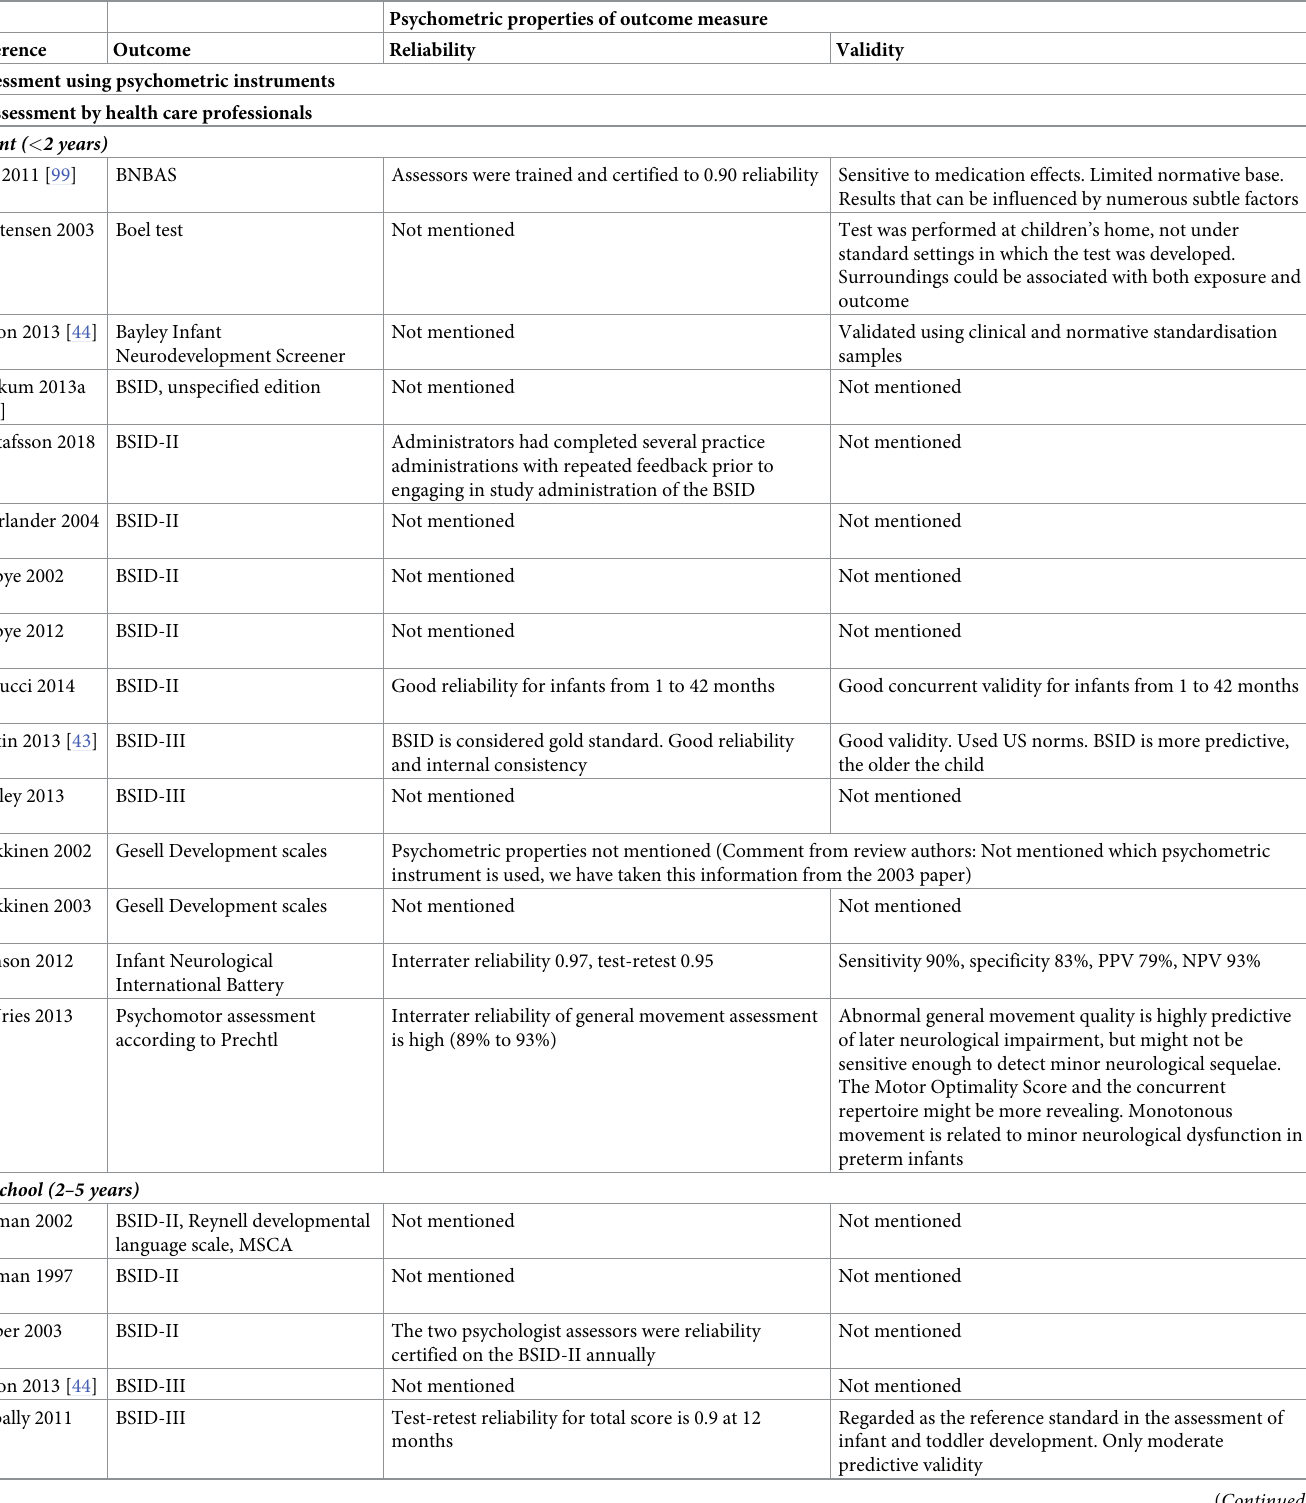
Table 1. Validity and reliability of outcome measures as reported by the authors of the study, papers on antidepressants. Psychometric properties of outcome